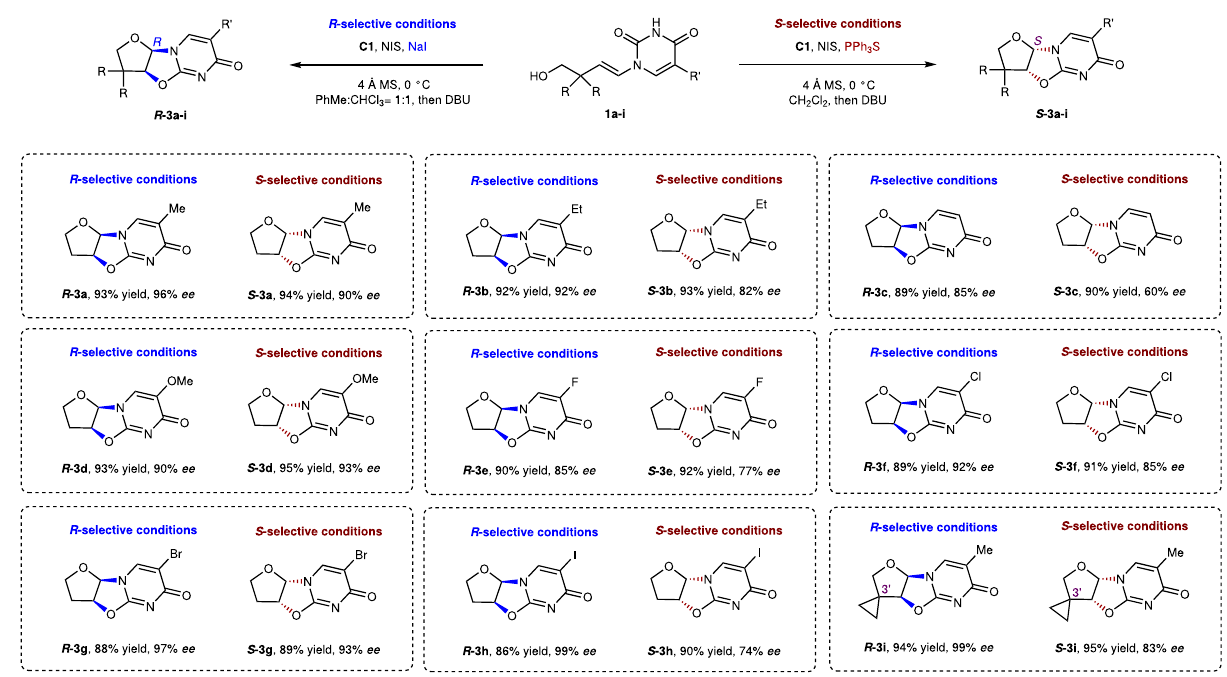
Fig. 2 | Substrate scope of tetrahydrofuran synthesis. R -selective conditions (blue): 1a - i (0.1mmol), C1 (0.01mmol), NaI (0.01mmol), NIS (0.11mmol), and 4Å MS(60mg/mmol),PhMe:CHCl 3 (1.2mL:1.2mL),0°Cfor8h,thenDBU(0.1mmol),